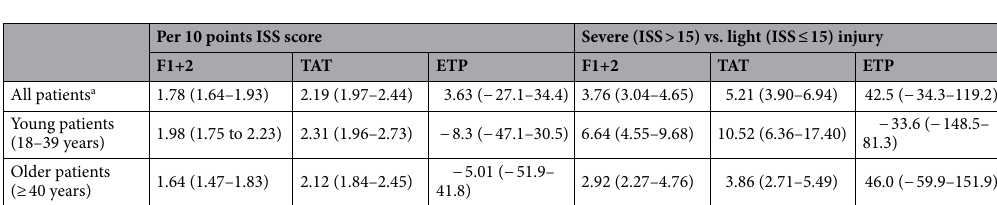
Table 3. Prothrombin fragment F1+2, thrombin-antithrombin complex levels and endogenous thrombin potential in relation to injury severity. F1+2, TAT complex levels and ETP in relation to ISS score. Results for all patients and by age-group displayed. Linear regression with ln(F1+2), ln(TAT) or ETP as dependent variable. Regression coefficients (beta coefficients) with 95% confidence interval presented. The ln-tranformed regression coefficients are back-transformed to linear scale before presentation. Abbreviations: ETP endogenous thrombin potential, F1+2 prothrombin fragment F1+2, ISS Injury Severity Score, TAT Thrombin- antithrombin complex levels. a Adjusted for